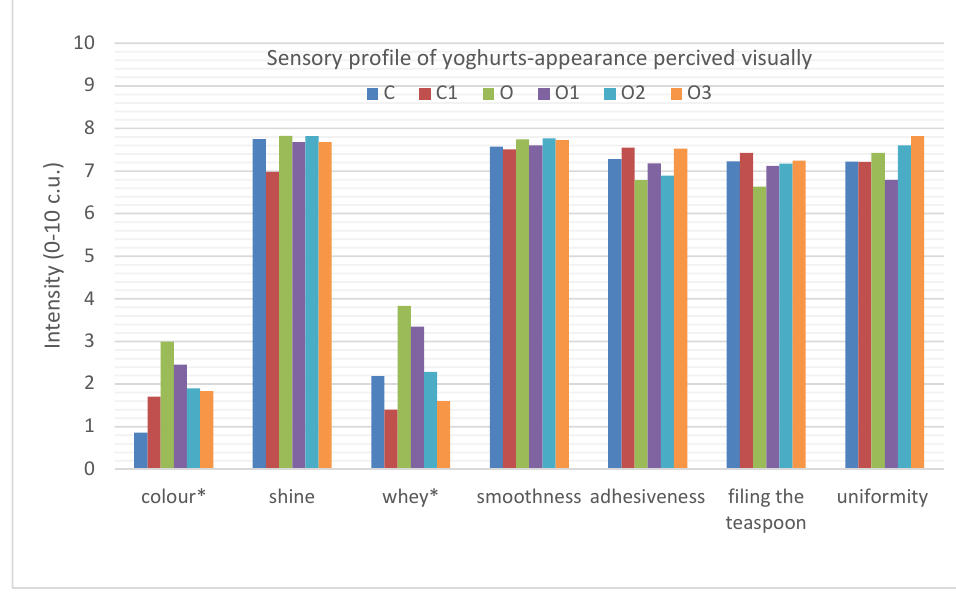
Figure 2. Sensory quality profile of yoghurts describing the appearance attributes perceived visually. C, control; C1, control with 6% inulin; O, oolong tea; O1, oolong tea with 3% inulin; O2, oolong tea with 6% inulin; O3, oolong tea with 9% inulin (* p ≤ 0.05 differ significantly). The analysed samples differed significantly statistically in colour intensity. The addition of oolong tea to natural yoghurt significantly changed the colour from light white to slightly dark creamy (C, 0.9 c.u.; O, 3.0 c.u., respectively). A similar relationship was white colour of 1.0 c.u. while the oolong tea-infused yoghurt was significantly darker at 3.2 c.u. The addition of inulin to the oolong tea-infused yoghurt had a significant effect on the lightening of the colour (O, 3.0 c.u.; O1, 2.5 c.u.; O2, 1.9c.u.; O3, 1.8 c.u.), in comparison